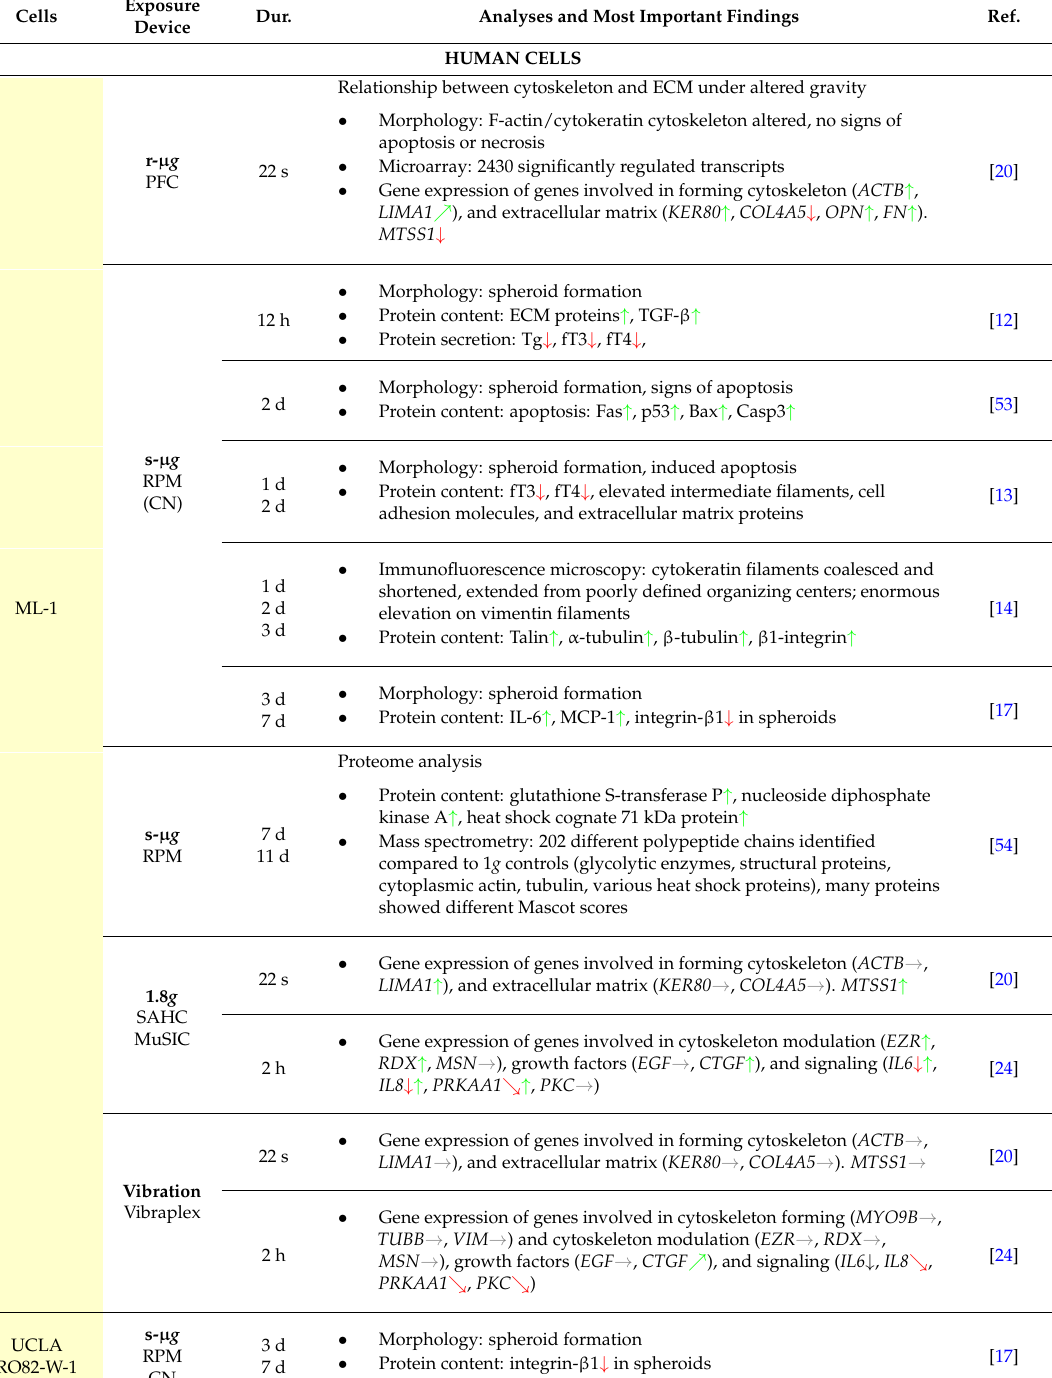
Table 1. Cont. Exposure Dur. Analyses and Most Important Findings Cells Device